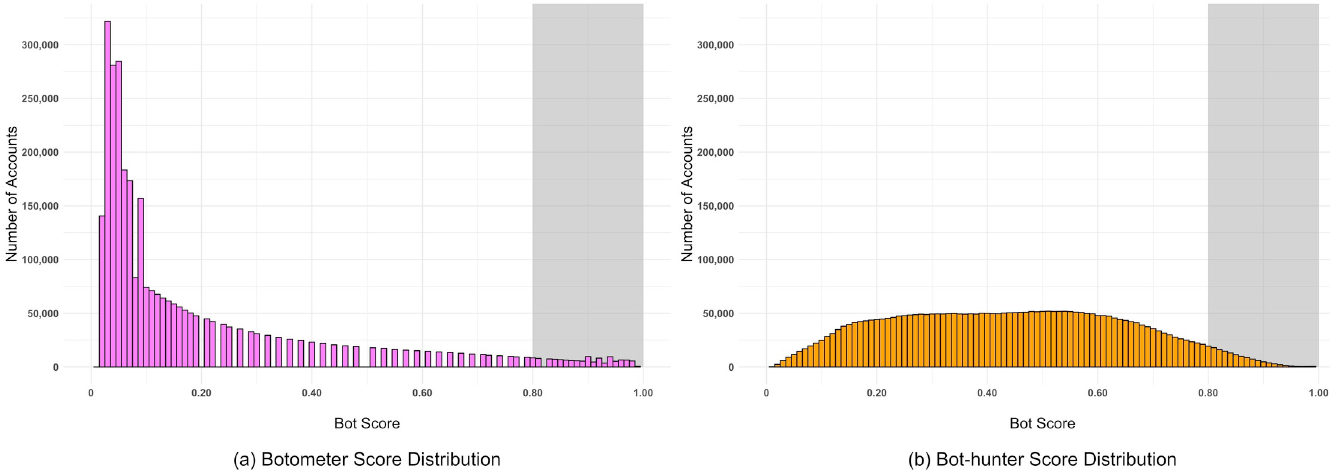
Fig 2. Resulting distribution of scores for Twitter accounts present within the 2018 U.S. midterm election tweet corpus using the (a) Botometer (pink) and the (b) Bot- hunter (orange) bot detection platforms.